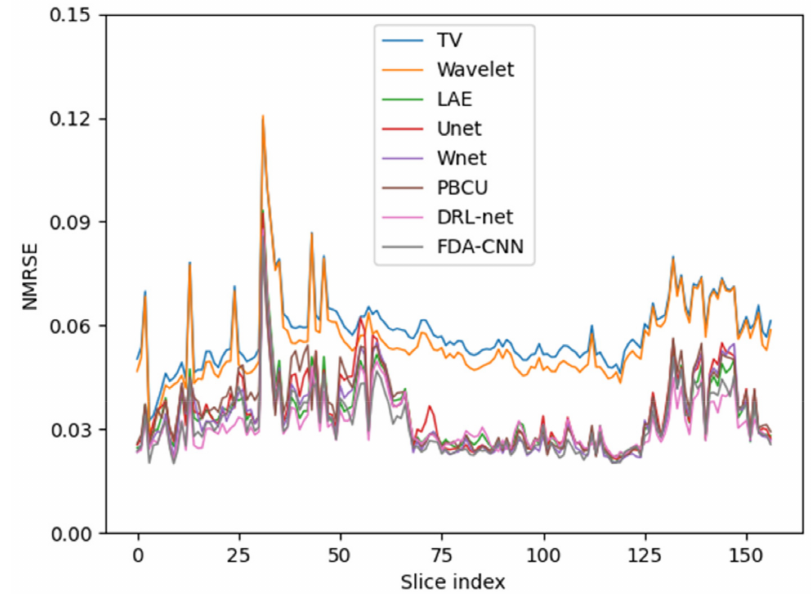
Figure 14. Average NRMSE variation across the slices. Edge slices have larger